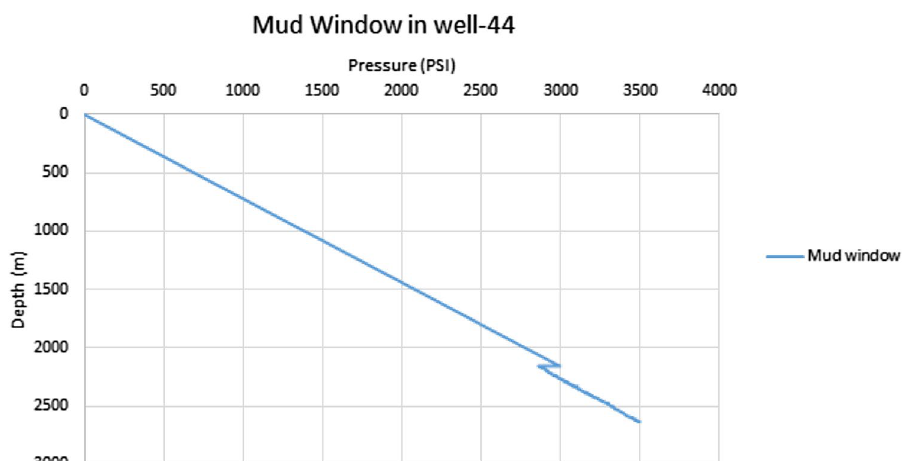
Fig. 9 The mud window calculated at well no. 44. The mud window indicates a slight decrease in the overpressure zone